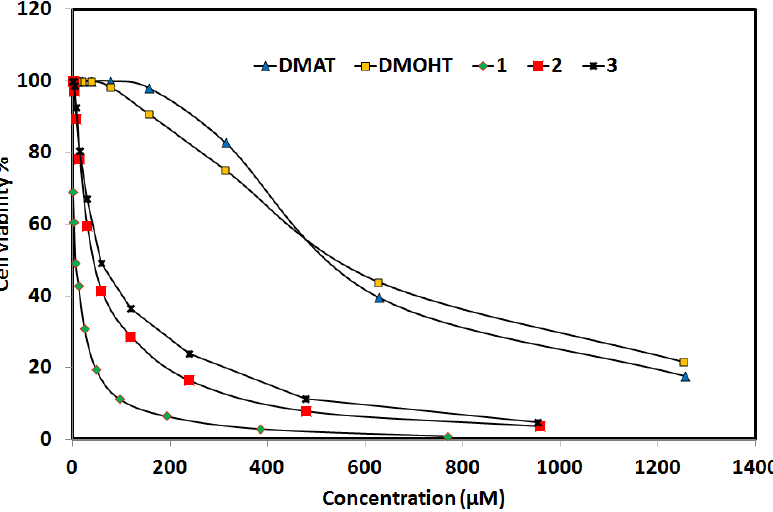
Figure 14. The cytotoxic activity of the studied compounds against normal human lung fibroblast MRC-5 cells.